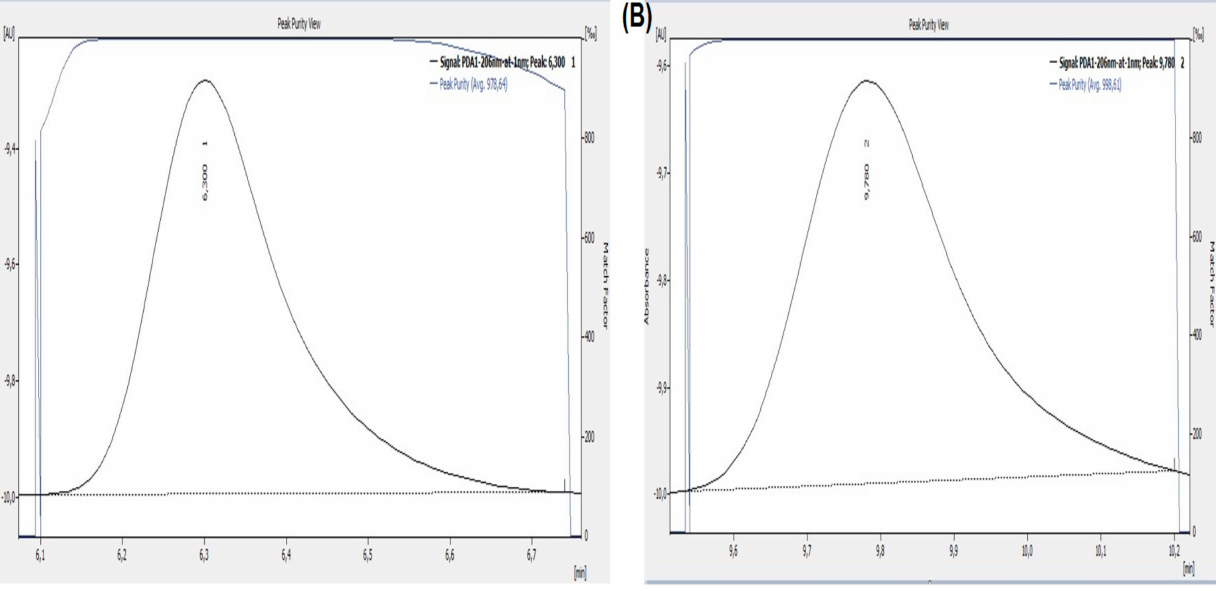
Figure 5. Peak purity data of ( A ) EH peak at 6.30 min (Average = 978.64) and ( B ) Brx peak at 9.78 min (Average =